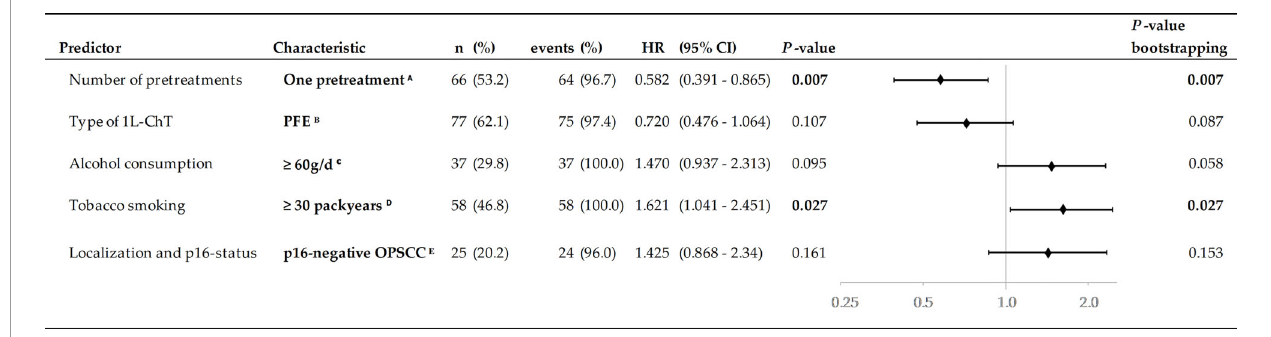
FIGURE 6 | Predictors in multivariate Cox proportional hazard regression (HR) and 2-sided P -values from internal validation using bootstrapping applying 1,000 iterations. Signi fi cant independent predictors P <0.005 are in bold. A Reference: 1L-ChT at initial diagnose or ≥ 2 pretreatments; B Reference: other 1L-ChT